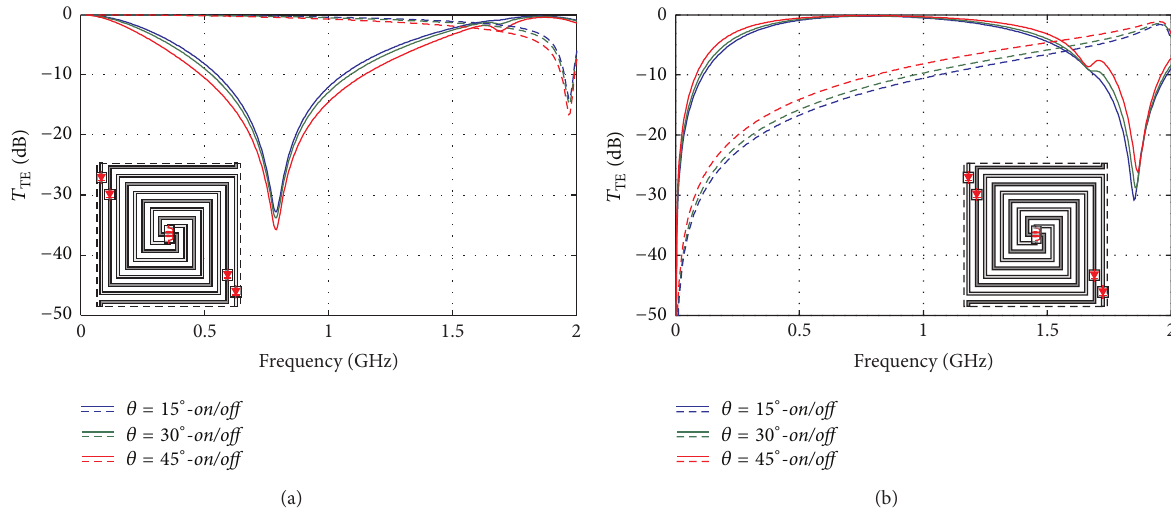
Figure 7: (a) Transmittance and (b) reflectance of the AFSS with the unit cell of Figure 1, modified with the introduction of two additional pin diode switches, at oblique incidence of TE waves when the pin diodes switches are in the on (solid lines) and off (dashed lines) states. The on and off states of pin diodes are modelled with their equivalent circuits of Figure